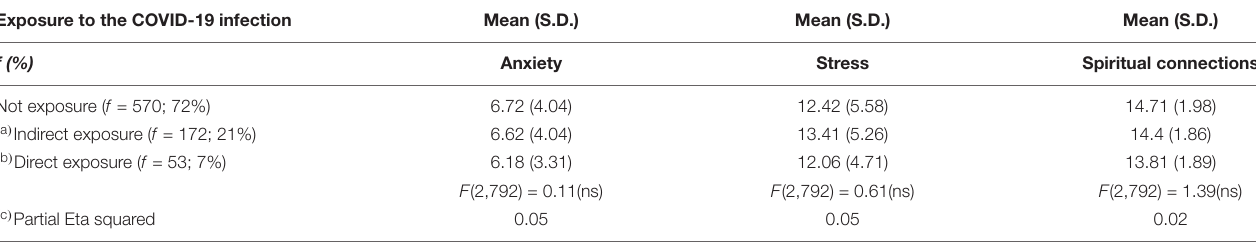
TABLE 2 | Analysis of variance (ANOVA) to determine significance of difference between those having direct and indirect exposure to the COVID-19 infection ( n = 795). Exposure to the COVID-19 infection Mean (S.D.) Mean (S.D.) Mean (S.D.)